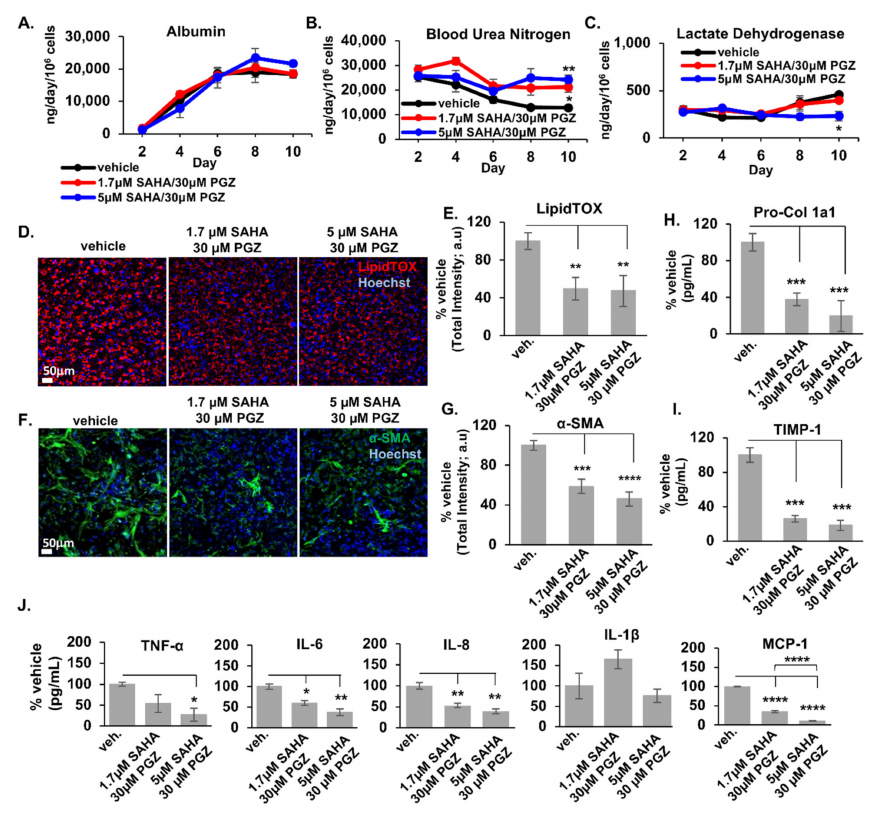
Figure 6. Pioglitazone and vorinostat used in combination result in the reduction of steatosis and stellate cell activation as well as the secretion of pro-fibrotic markers and production of